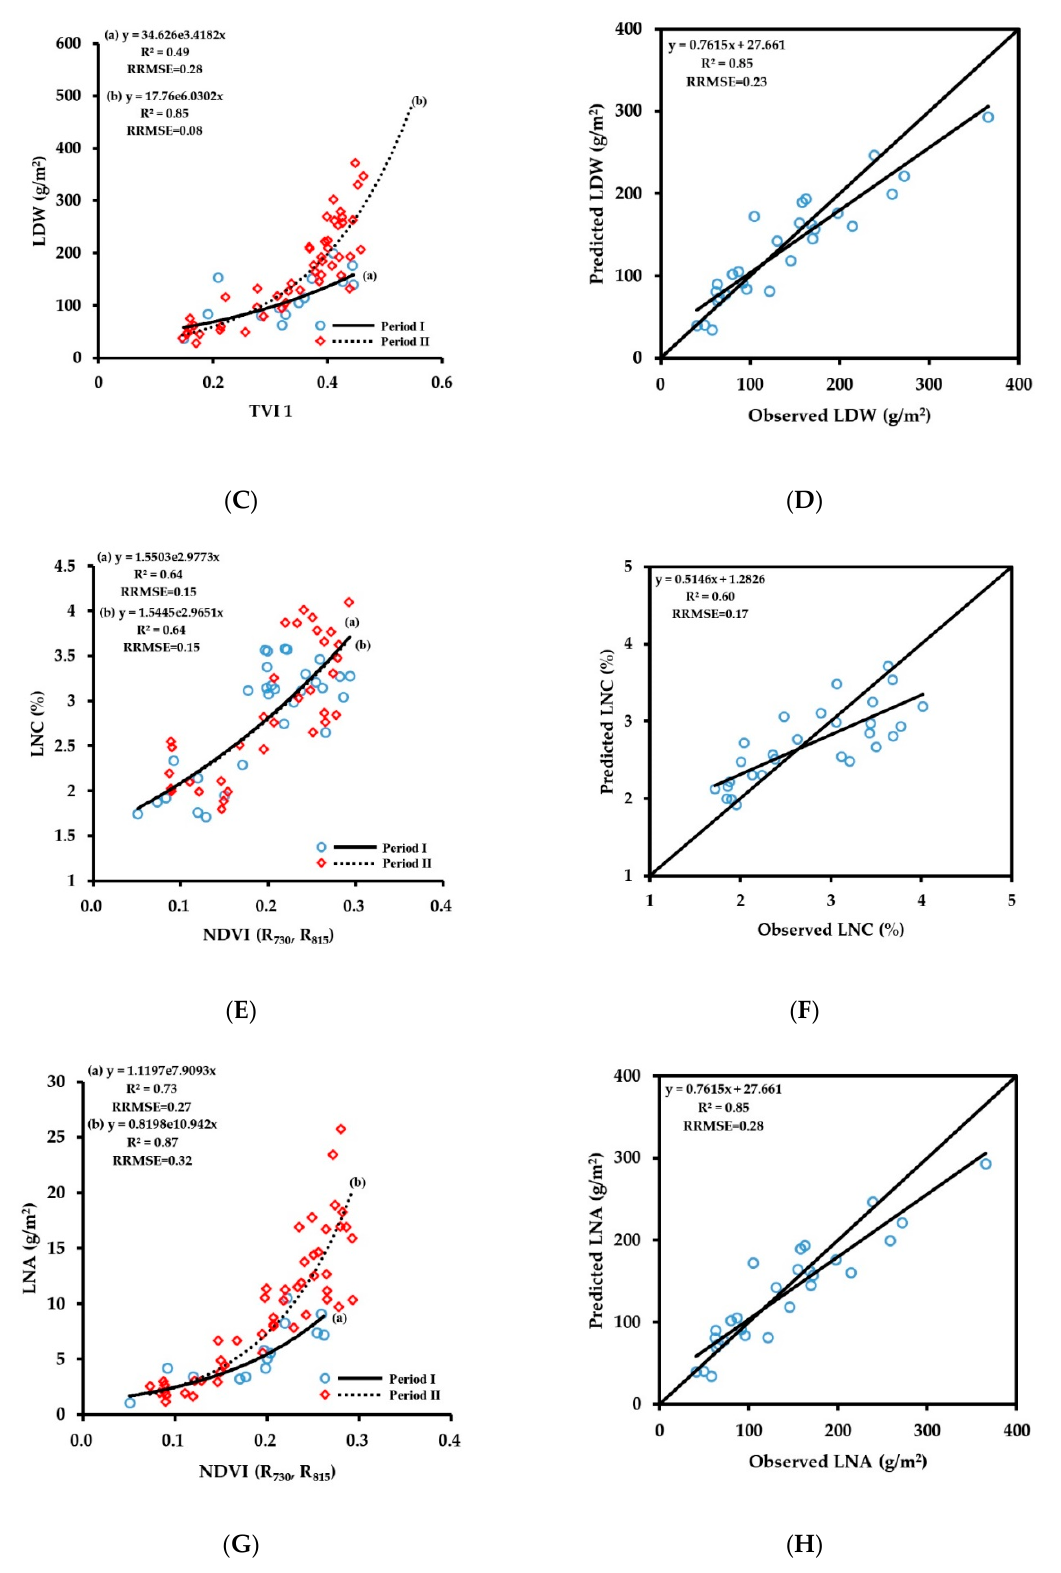
Figure 15. Fitting curves of vegetation index to LAI ( A ), LDW ( C ), LNC ( E ) and LNA ( G ) of wheat at period Ⅰ and period Ⅱ ; The relationships between observed and predicted LAI ( B ), LDW ( D ), LNC ( F ) and LNA ( H ) values based on the multi-stage monitoring model of wheat.